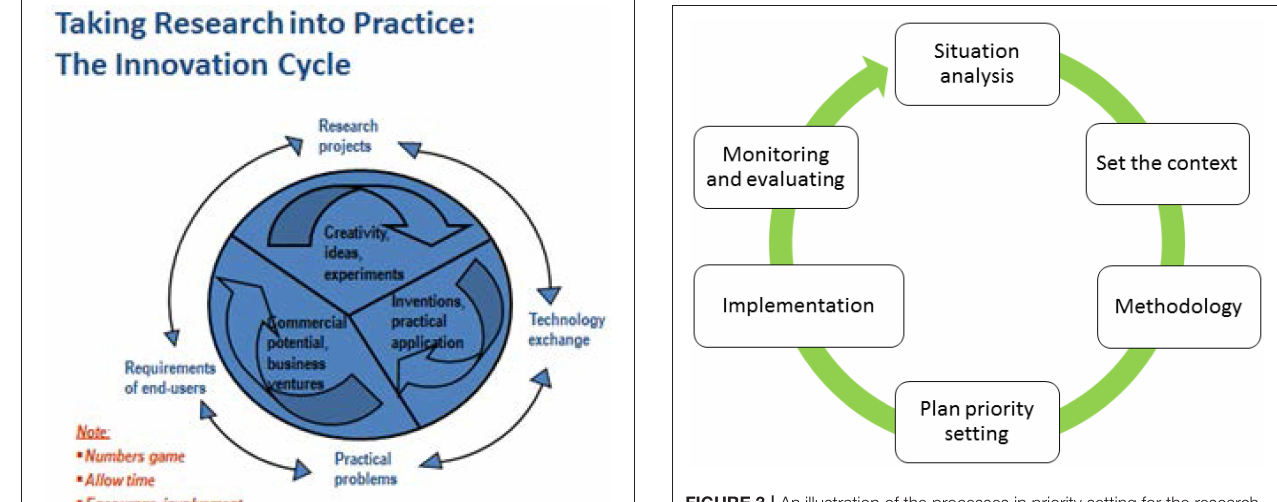
FIGURE 3 | An illustration of the processes in priority setting for the research, development and innovation roadmap for neglected and underutilized crops in South Africa. The process starts with a situation analyses, which then leads to establishing the context and developing appropriate methodologies. This is followed by setting the priorities and developing a plan for implementation, monitoring and